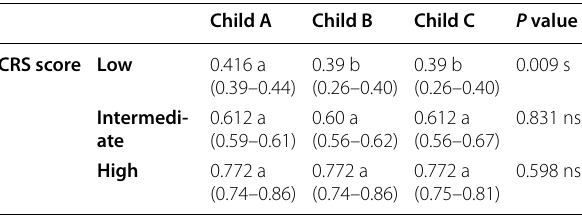
Identical letters in rows mean no significant difference at the level of 0.05 Different letters in rows mean significant difference at the level of 0.05 s means significant ns means not significant